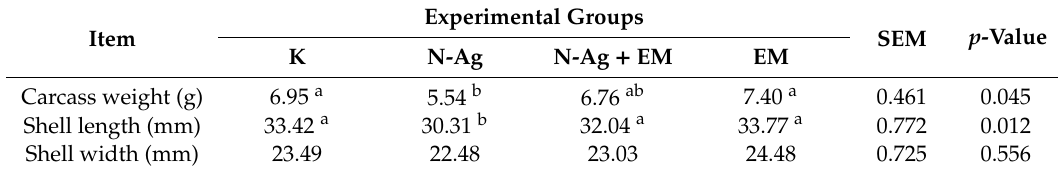
Table 4. Carcass weight and shell size of Cornu aspersum (Müller) snails in the control and experimental groups.